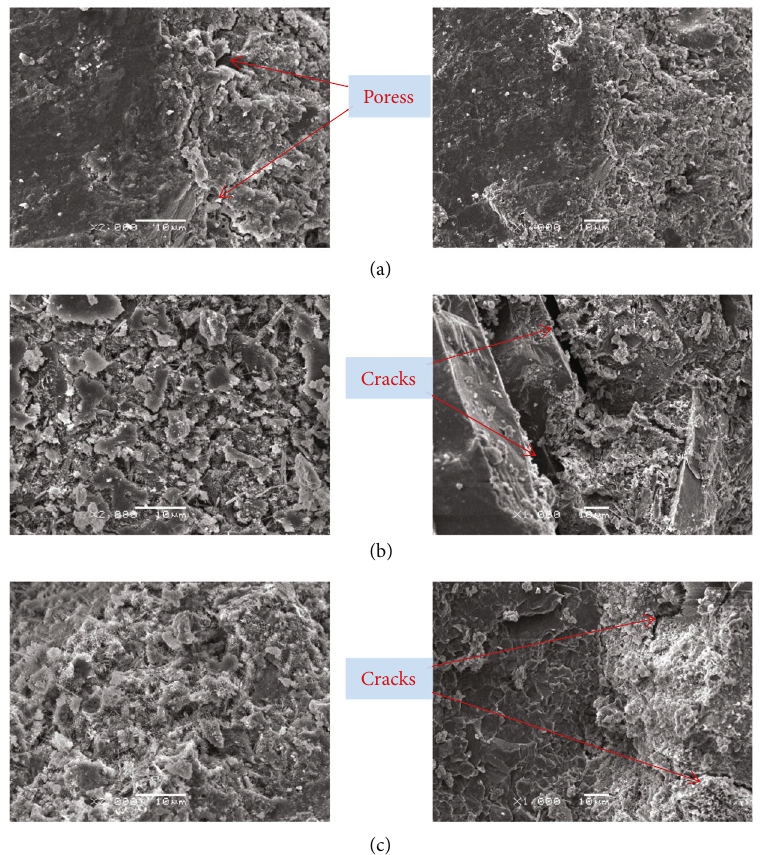
Figure 8: SEM images of the microstructure: (a) C; (b) RC; (c) MRC.